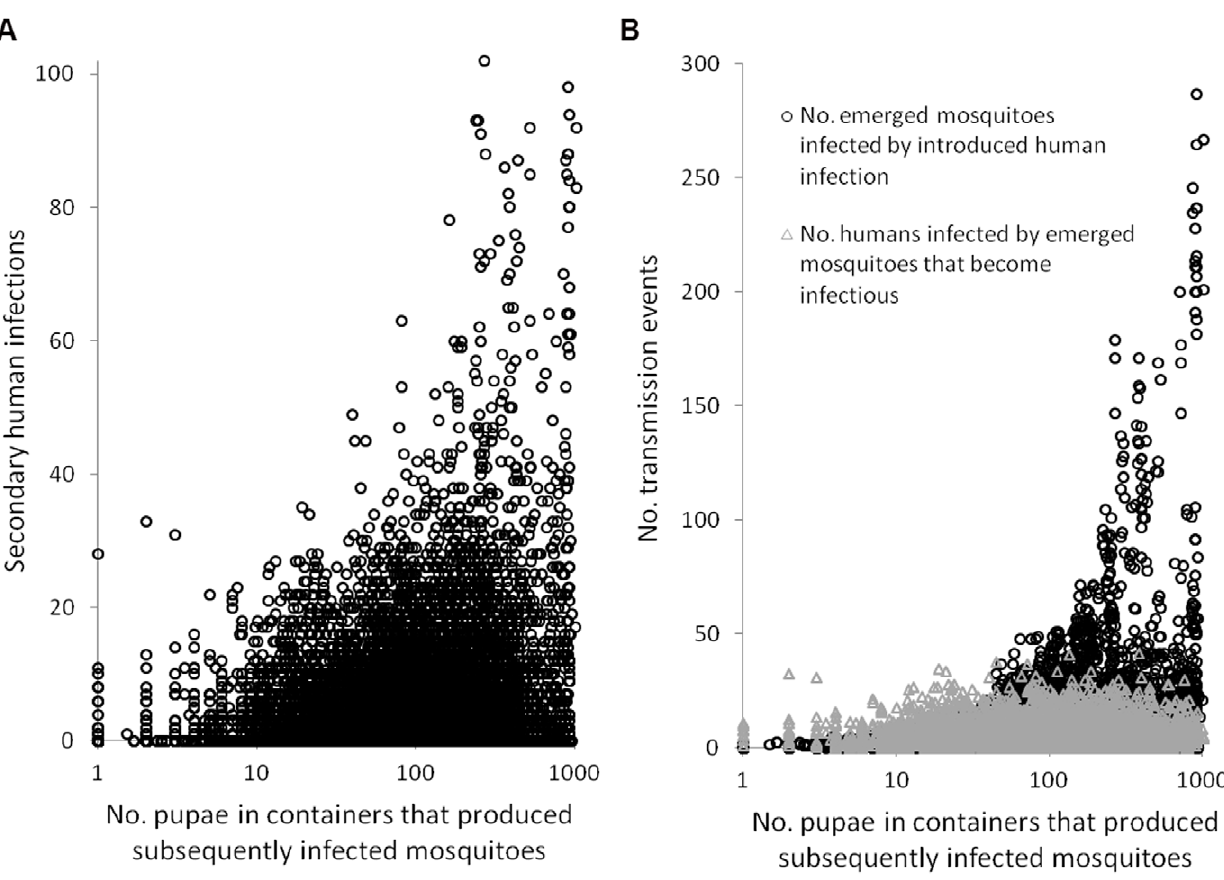
Figure 5. Pupae per container and transmission in subsequently emerged mosquitoes. (a) Effect of pupal abundance on human-to- mosquito infection (no. subsequently emerged mosquitoes infected by introduced human infection) and mosquito-to-human infection (avg. number of. humans infected by subsequently emerged mosquitoes that became infected); (b) Effect of pupal abundance in containers that produce infected mosquitoes on avg. number of secondary infections.